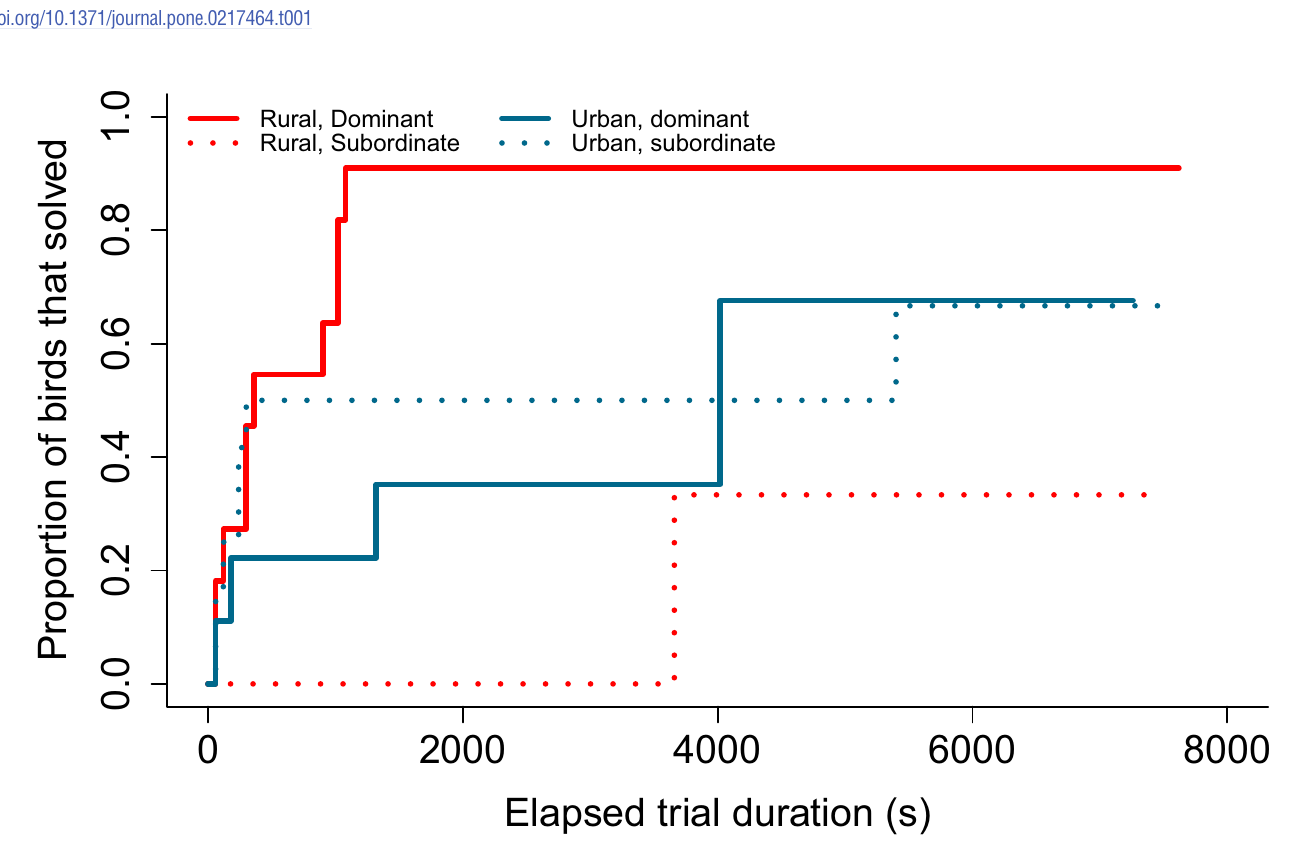
Fig 3. Relationship between dominance score and proportion of individuals that solved the lever-pulling task over two